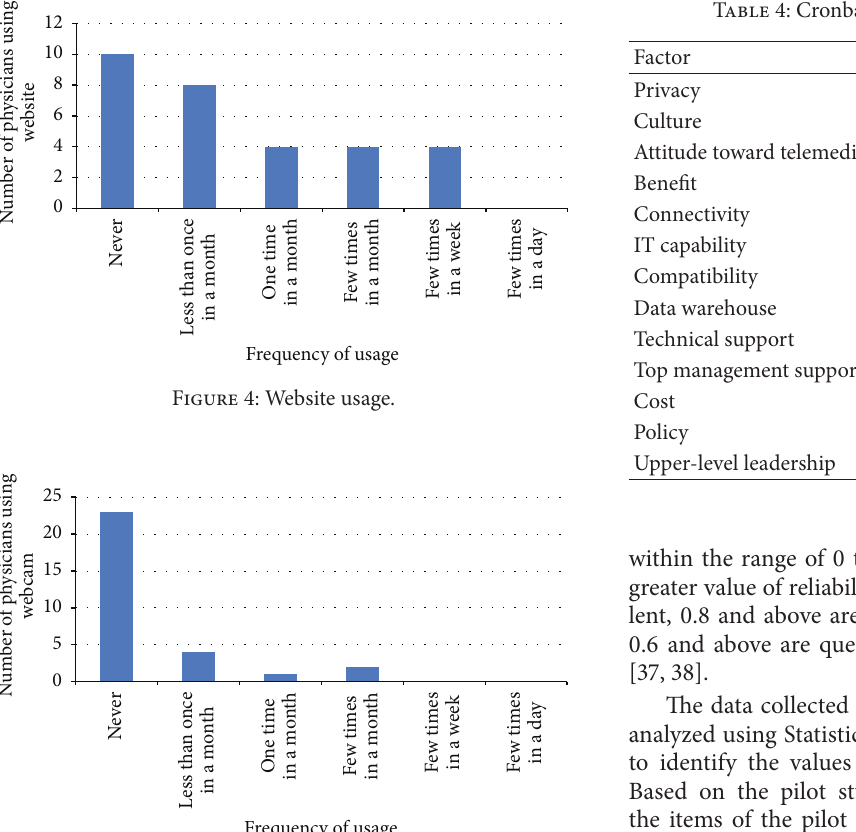
Figure 5: Webcam usage.